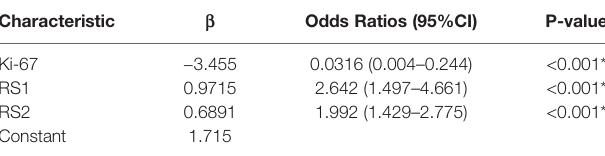
*Indicates a statistical difference between the Responder group and Non-Responder